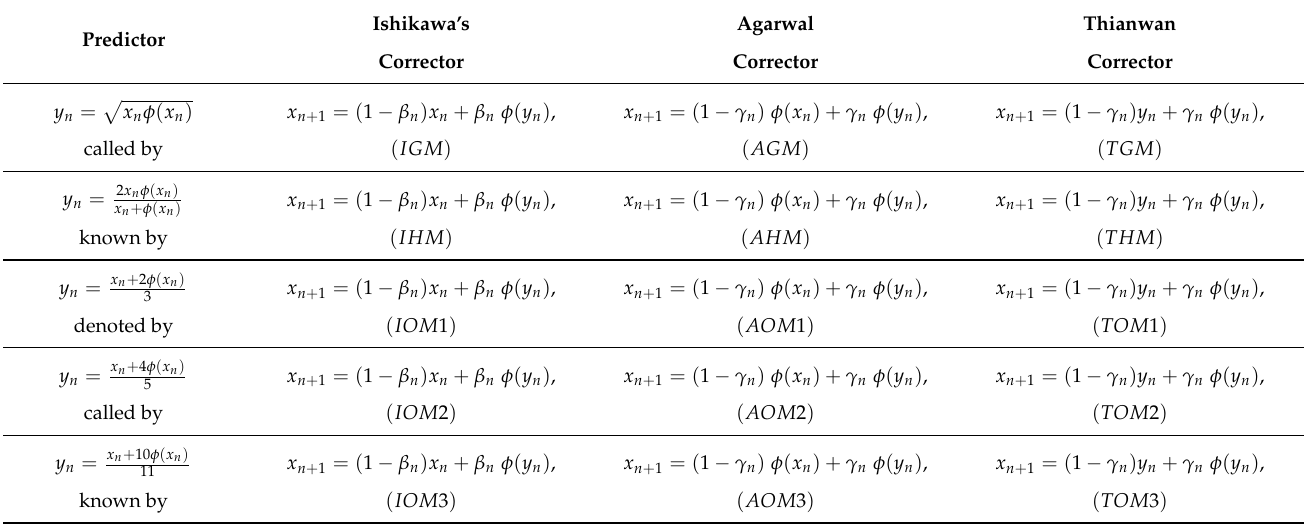
Table 1. Some modified schemes based on Ishikawa’s, Agarwal and Thianwan as corrector, respectively.